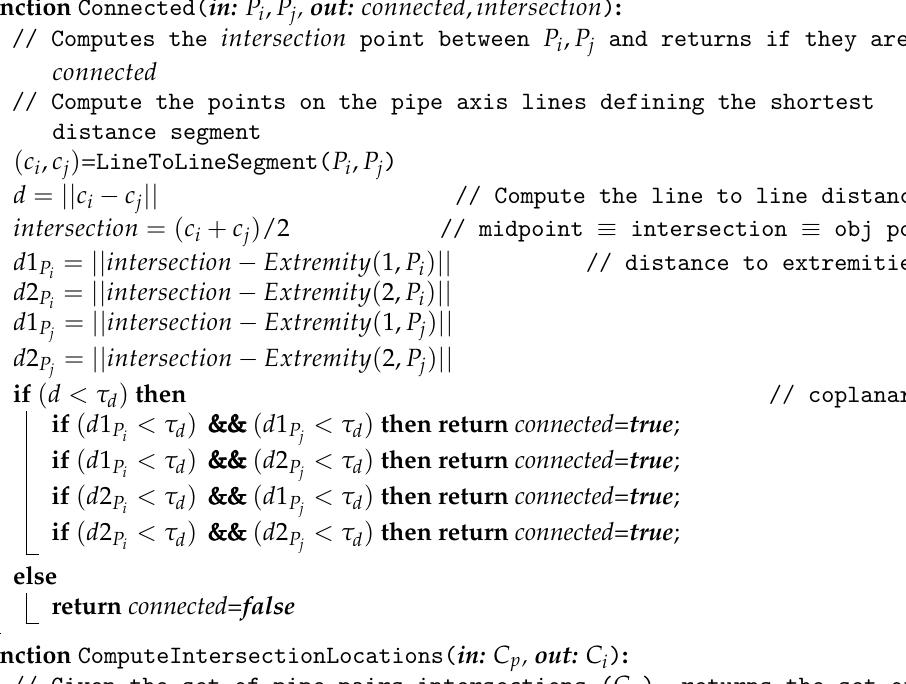
Algorithm 2: Semantic